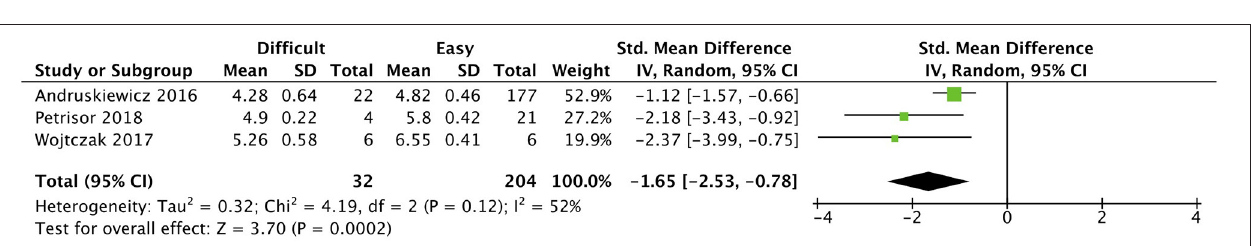
FIGURE 9 | HMD in extended position forest plot comparing difficult and easy laryngoscopy